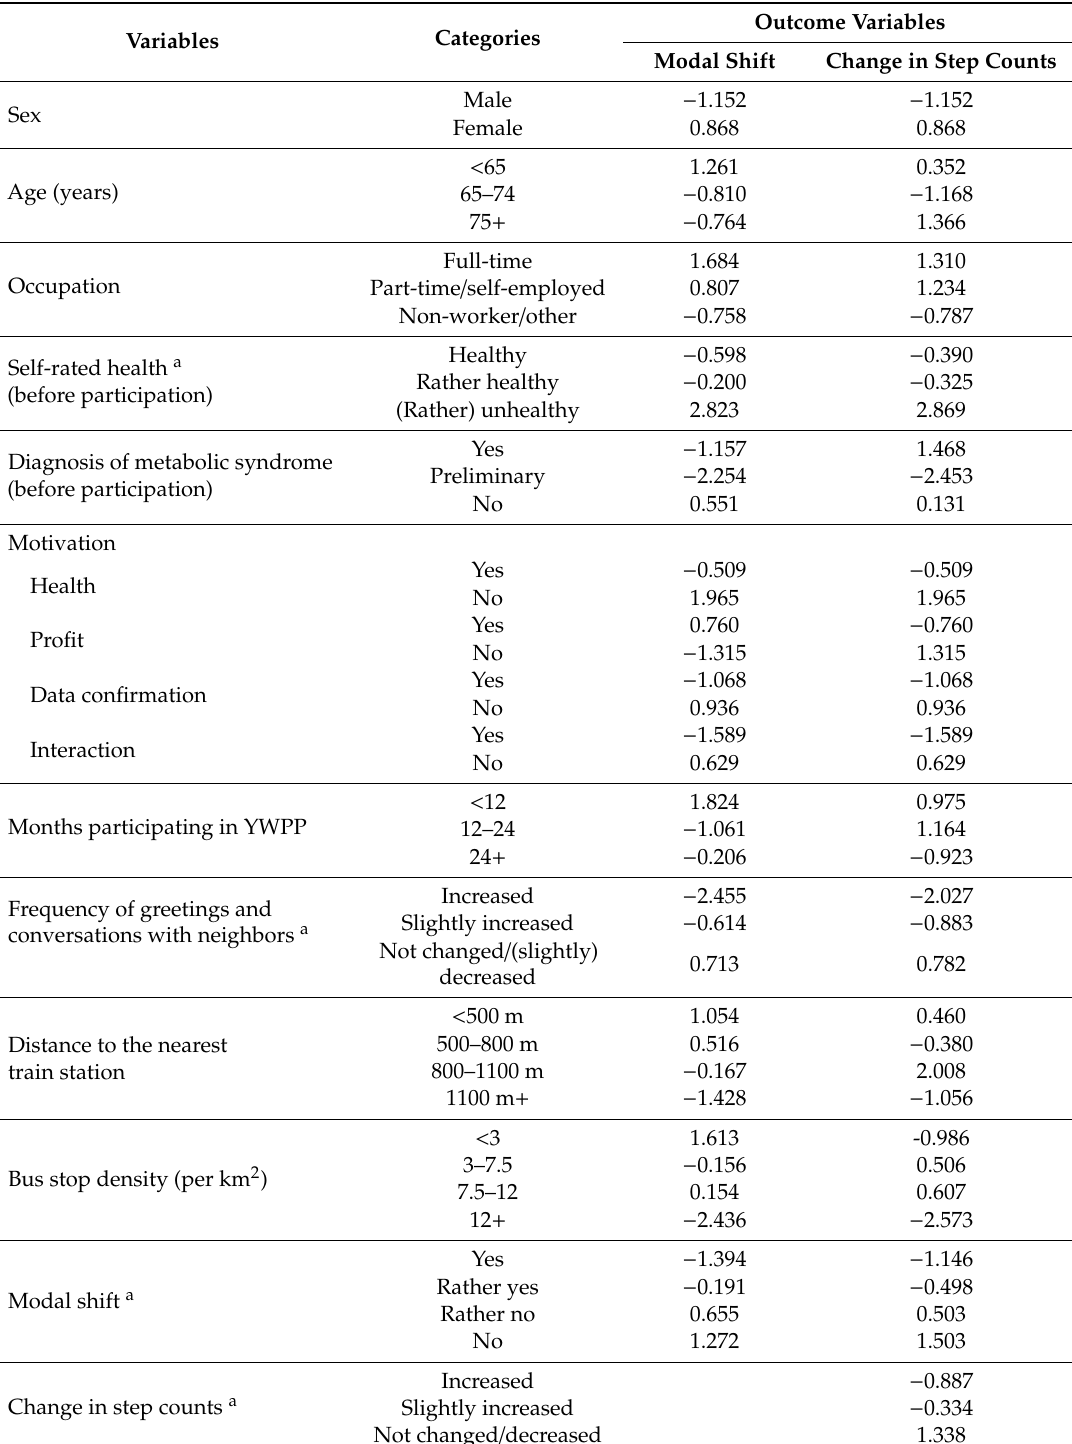
Table 3. Numerical values assigned to the